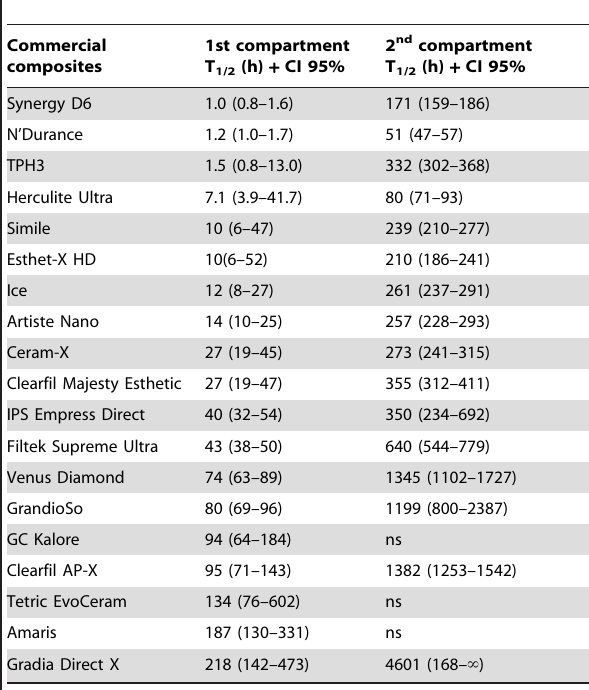
Figure 4. Decay curves recorded in X-band (top) and L-band (bottom) for the Clearfil Majesty Esthetic composite. Decay curves were measured for 5 samples.